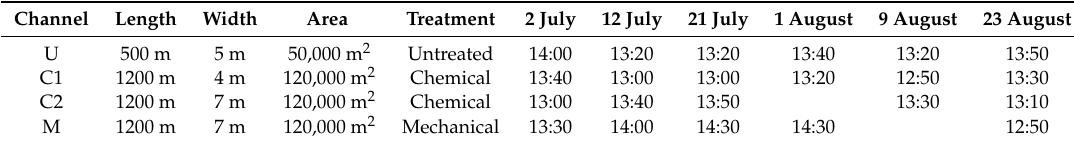
Table 2. The untreated channel (U) had no weed control applied. The mechanical treatment channel (M) had excavator de-silting carried out on 23 July 2018. The two chemical treatment channels (C1 and C2) had Endothall herbicide applied on 11 July 2018. Table 2. Channels used for UAV image captures, the approximate total image area captured, and the dates and times of the captures (all in